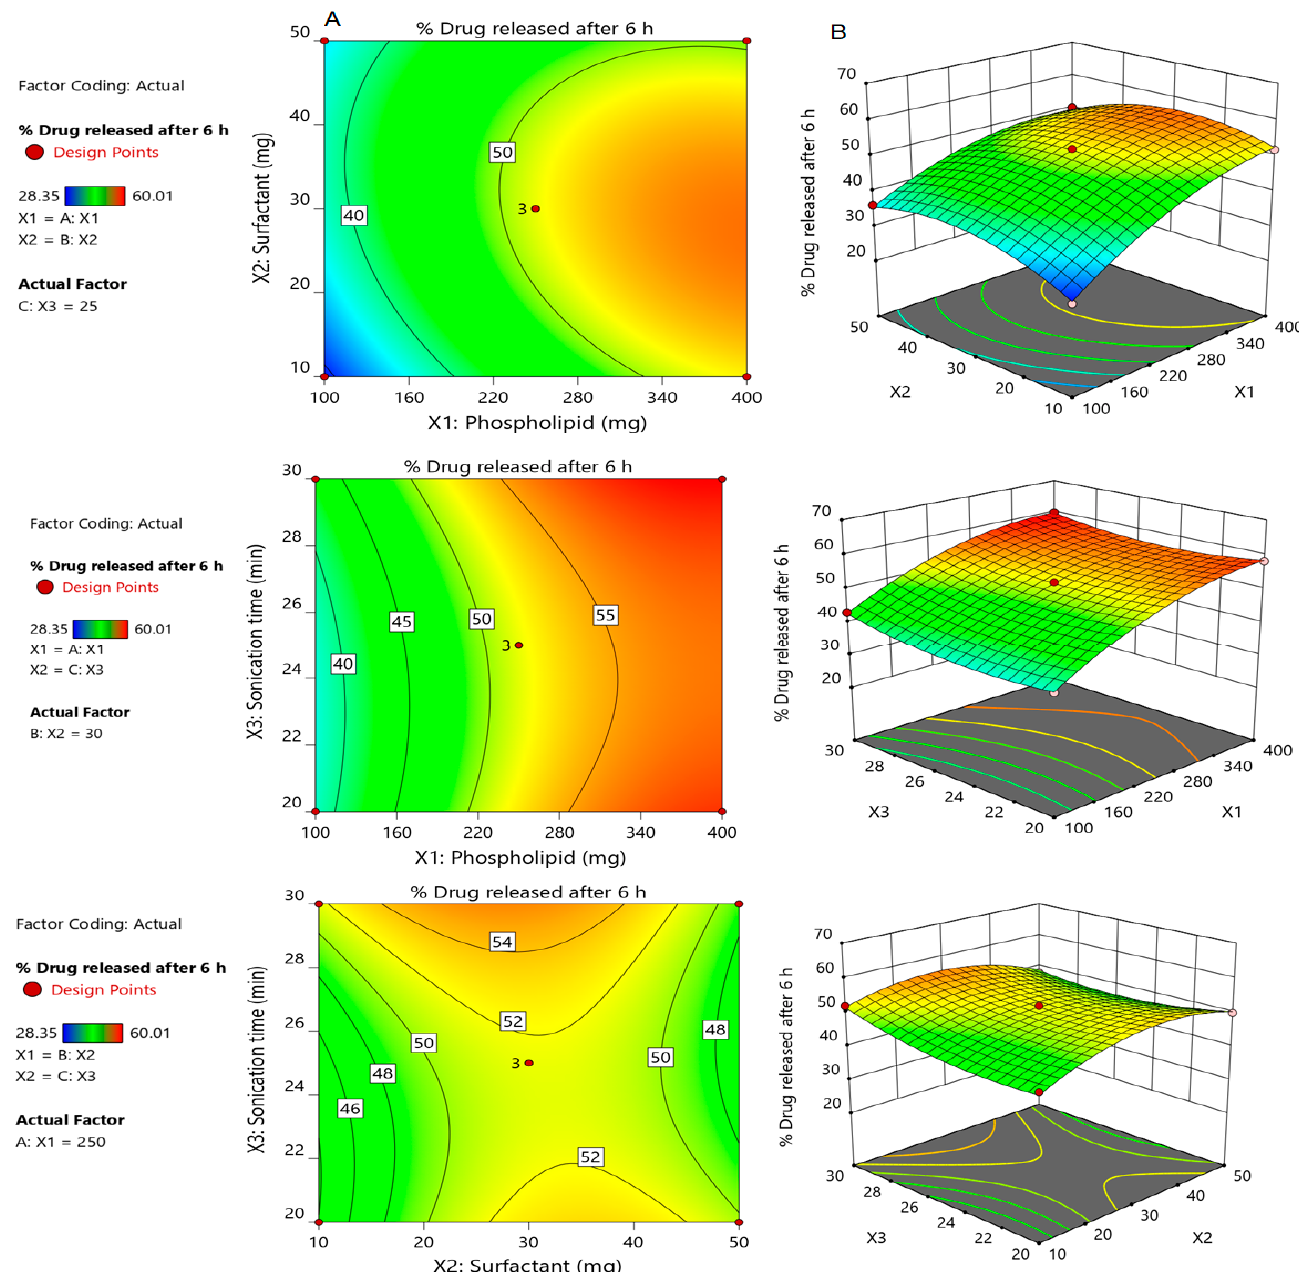
Figure 2. Contour plots ( A ) and corresponding response surface plots ( B ) which show effects of the independent variables on percentage drug released after 6h (Y 2 ). Two independent variables are considered at a time, while the third one remains constant.